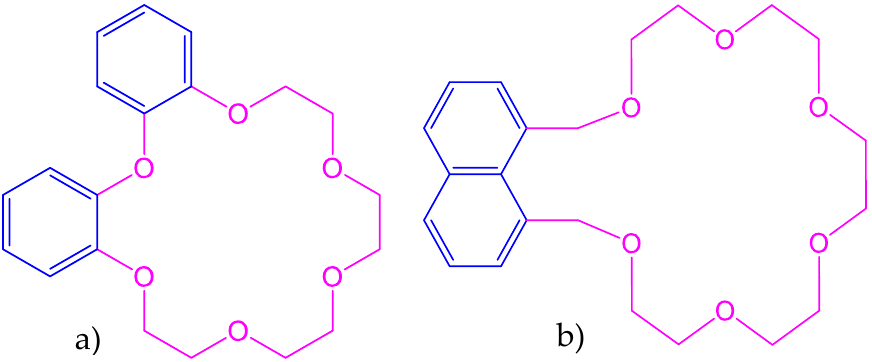
Figure 11. Structures of dibenzo-18-crown-6 (DC) and 1,8-naphtho-21-crown-6 ether ( 15a – b ).